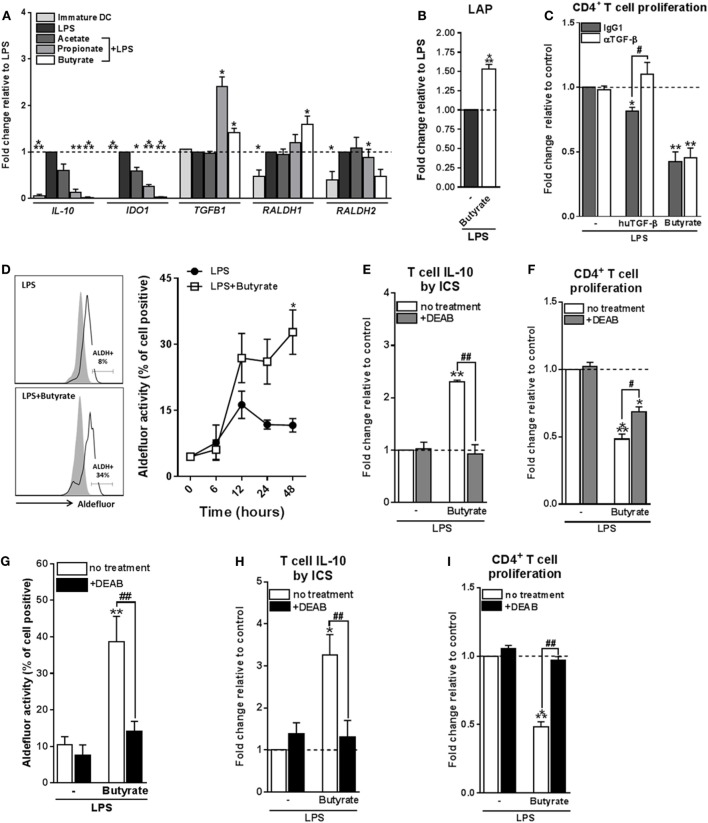
Type 1 regulatory T cell induction by butyrate-conditioned human dendritic cells (DCs) depends on retinaldehyde dehydrogenase 1 (RALDH1) expression. (A) mRNA expression of indicated genes was quantified using real-time qPCR of monocyte-derived DCs stimulated for 16 h. (B) Relative membrane bound latency-associated peptide (LAP) expression on DCs stimulated with indicated reagents as determined by flow cytometry. (C) T-cell suppression assay as described in Figures 2D, (F) blocking antibody of human TGF-β was added during the co-culture of DCs with T cells. Human TGF-β was taken along as positive control. (D) Retinaldehyde dehydrogenase (RALDH) activity in DCs was assessed using an Aldefluor assay with a readout by flow cytometry. Representative histograms of RALDH activity 48 h after stimulation are shown on the left, with gray shaded histograms and black lines representing DCs in which RALDH activity was assessed in the presence or absence of reversible RALDH inhibitor diethylaminobenzaldehyde (DEAB), respectively. Right graph: RALDH activity was measured at different times after stimulation and frequencies of DCs positive for RALDH activity are depicted. *p < 0.005 based on two-way ANOVA test. (E) IL-10 production by T cells as described in Figure 2B or (F) T-cell suppression assay as described in Figure 2D, but with the addition that DEAB or vehicle control was added during the DC–T cell coculture. (G) RALDH activity assay as described in Figure 3D, but during stimulation DEAB or vehicle control were added. (H,I) Same as (E,F), but now DEAB was added during stimulation of DCs with LPS ± butyrate. (A–I) Bar graphs represent means ± SEM of at least three experiments and (A–C,F,G,I) are shown as fold change relative to control conditions. *,#p < 0.05, **,##p < 0.01, ***p < 0.001 for significant differences with the control (*) or between test conditions (#) based on paired Student’s t-test.